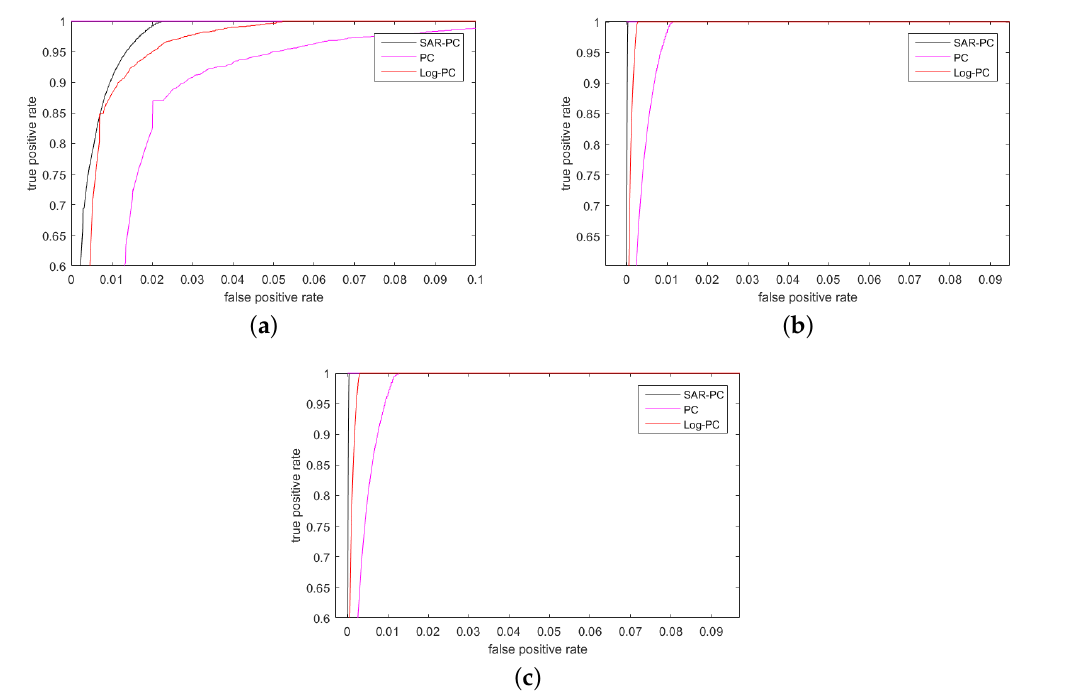
Figure 12. ( a ) ROC curves on one-look simulated SAR image (Step and Roof); ( b ) ROC curves on three-look simulated SAR image (Step and Roof); ( c ) ROC curves on six-look simulated SAR image (Step and